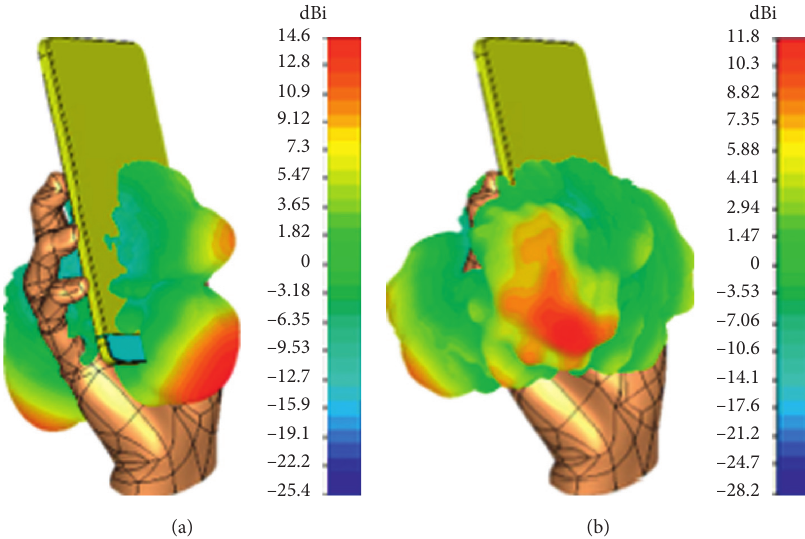
Figure 9: Antenna array radiation patterns for MBS integrated into the form factor with the hand grip. Each plot’s colorbar refers to its maximum value with a common dynamic range of 40dB: (a) ψ � 90 ° ; (b) ψ � 70 °